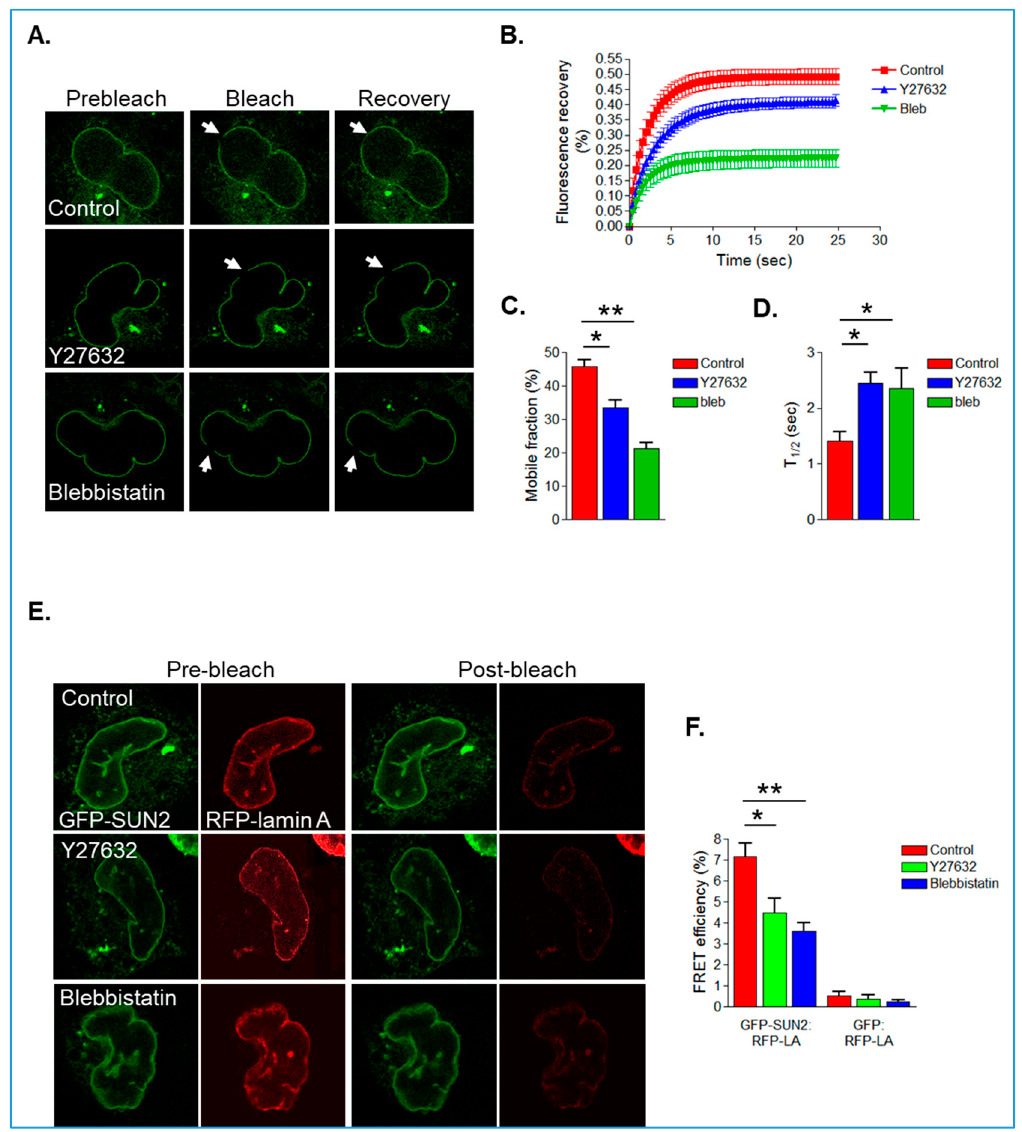
Figure 6. Actomyosin activity increases SUN2 mobility and the interaction between SUN2 and lamin A. ( A ) Representative prebleach, bleach, and recovery images of control, Y27632- and blebbistatin-treated GFP-SUN2 expressing VSMCs grown on 12 kPa hydrogels (arrow marks the bleached region). Graphs show ( B ) fluorescence recovery profile, ( C ) mobile fraction, and ( D ) T1/2 of GFP-SUN2 recovery in control ( n = 21), Y27632 ( n = 18)-, and blebbistatin ( n = 22)-treated VSMCs (* p < 0.05 and ** p < 0.01). ( E ) Representative prebleach and post-bleach images of control, Y27632-, and blebbistatin-treated VSMCs expressing GFP-SUN2 and RFP-lamin A grown on 12 kPa hydrogels. ( F ) Graph shows GFP-SUN2/RFP-lamin A and GFP/RFP-lamin A FRET efficiency of control ( n = 22), Y27632 ( n = 19)-, and blebbistatin ( n = 24)-treated VSMCs (* p < 0.05 and ** p < 0.01).